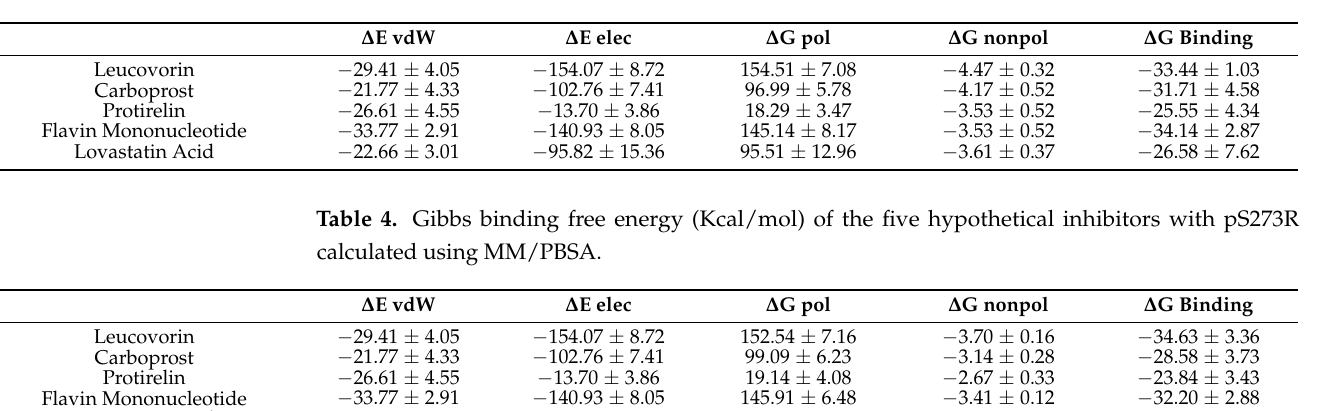
Table 3. Gibbs binding free energy (Kcal/mol) of the five hypothetical inhibitors with pS273R calculated using MM/GBSA.